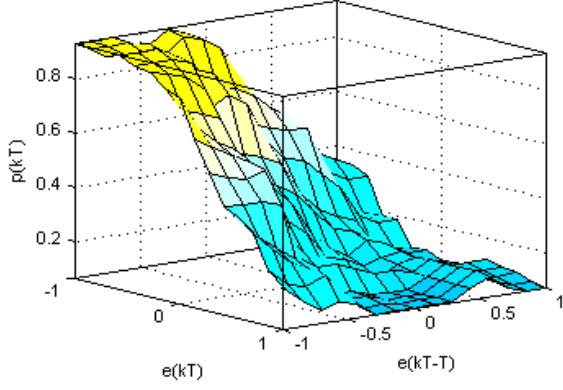
Figure 11. Inference surfaces of FNNRED after